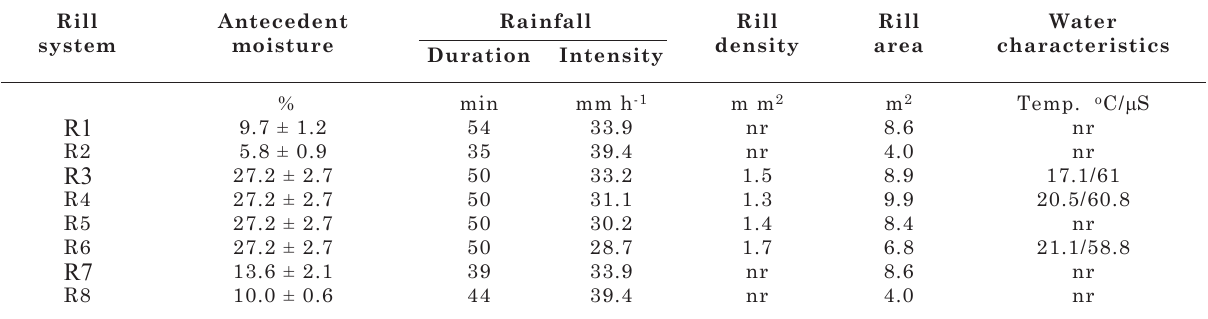
table 1. Rill system and rainfall simulation characteristics Rill